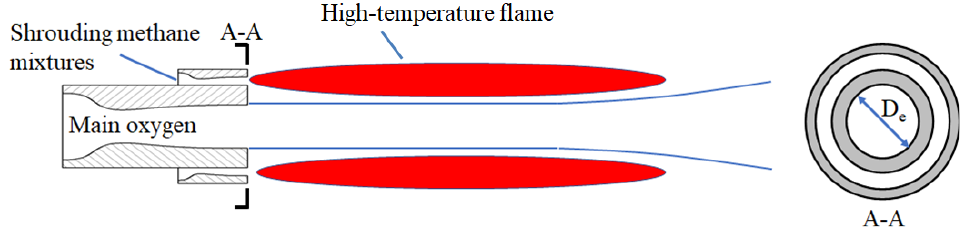
Figure 1. Structure diagram of the supersonic combustion coherent jet nozzle.